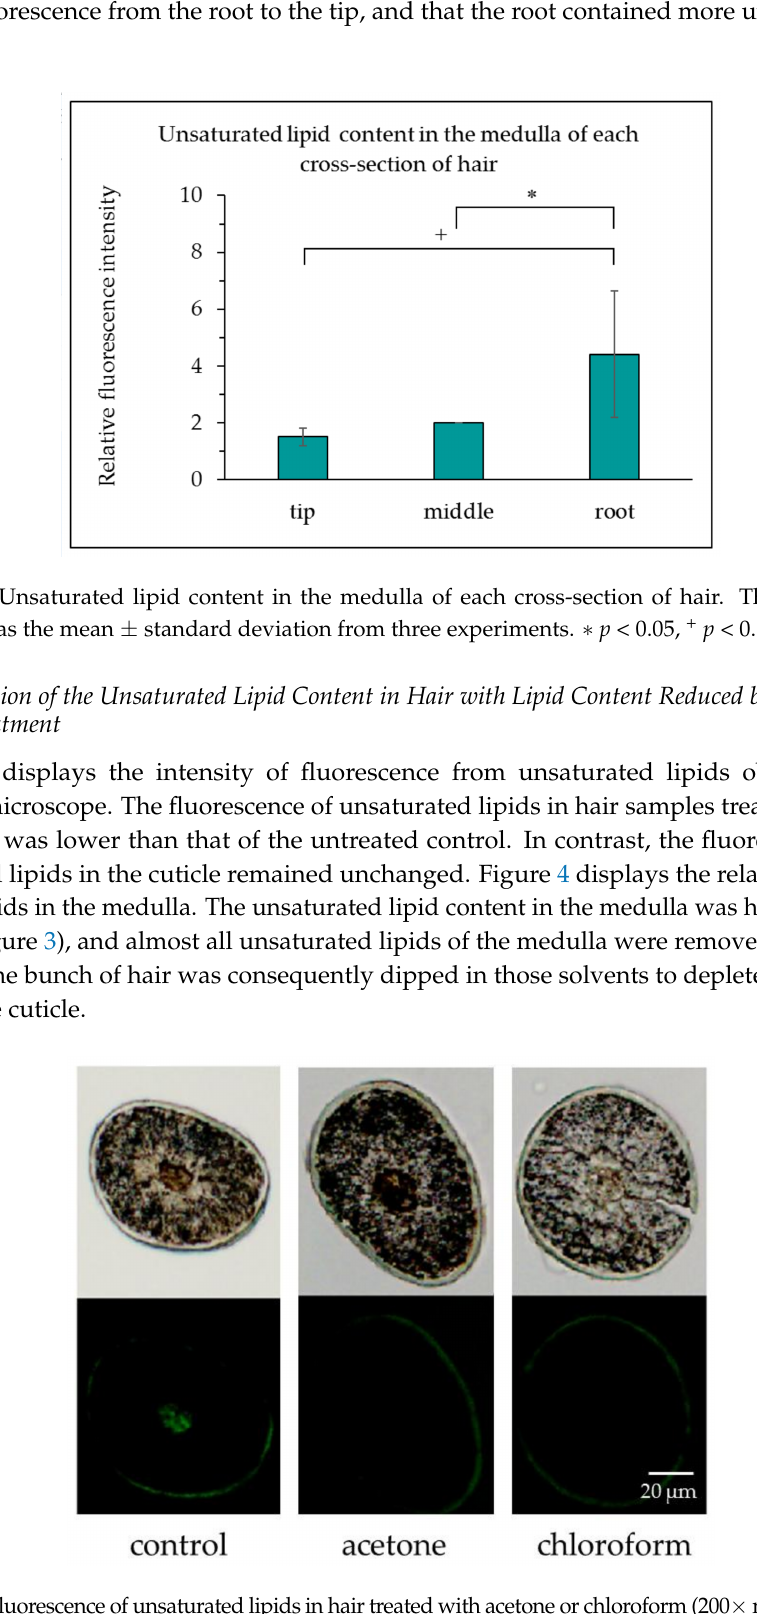
Figure 3. Fluorescence of unsaturated lipids in hair treated with acetone or chloroform (200 ×